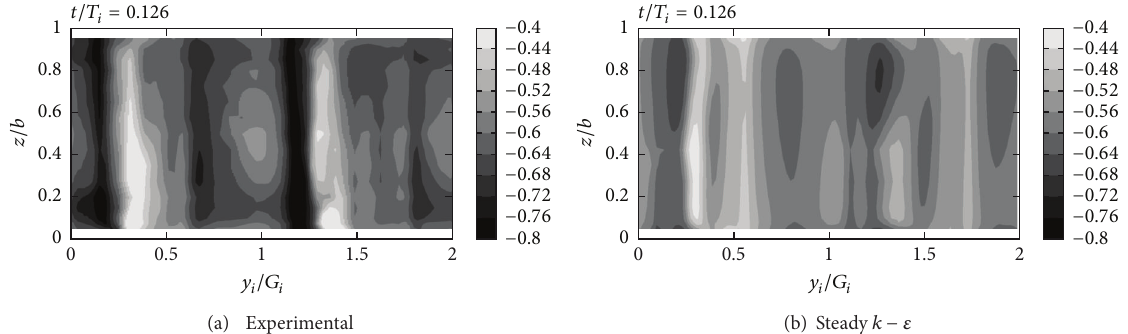
Figure 4: Experimental and calculated tangential velocity fields in the radial gap for the steady-state simulation using the 𝑘 − 𝜀 turbulence model.